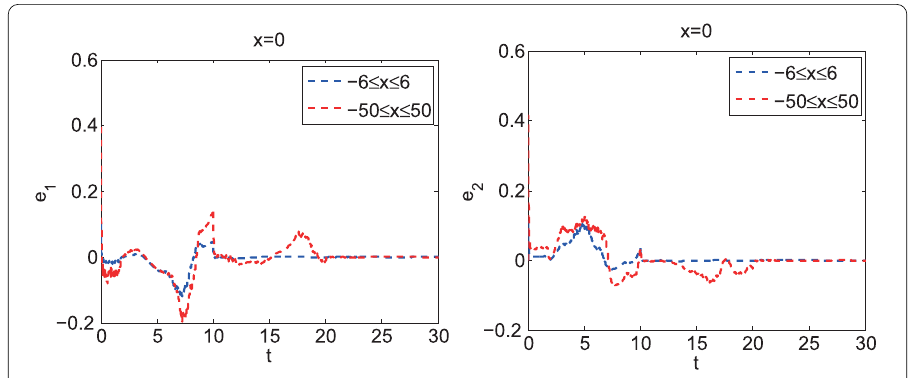
Figure 6 Asymptotic behaviors of the synchronization errors with differential diffusion